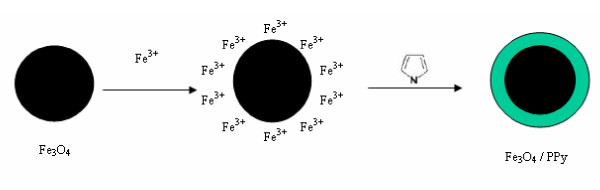
Scheme of the formation processes of the as-produced Fe3O4@PPy NPs.